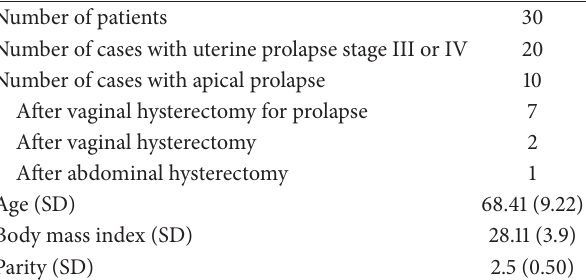
Table 1: Patients characteristics: sample means and